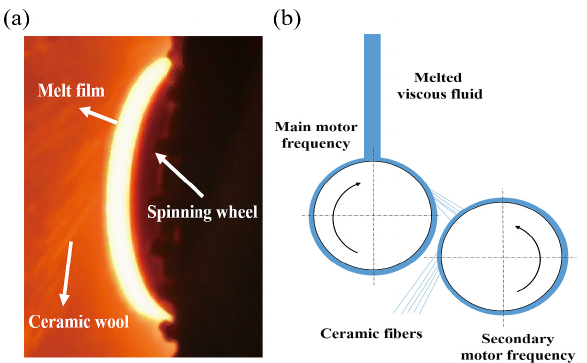
Figure 1. ( a ) The actual forming process of the ceramic wool on the rotating wheel; ( b ) The schematic diagram of the process.